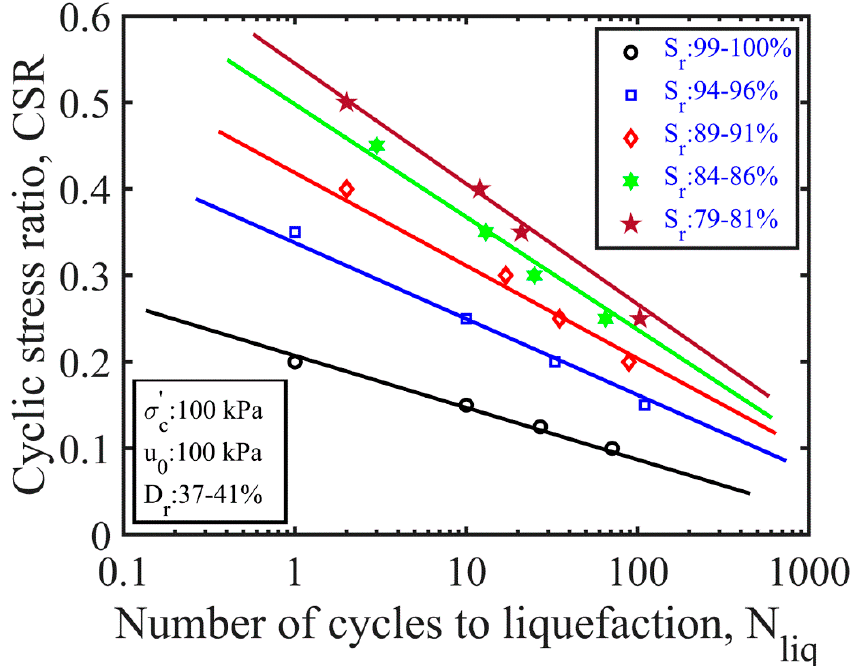
Figure 9. Effect of degree of saturation on liquefaction resistance of partially saturated specimens.